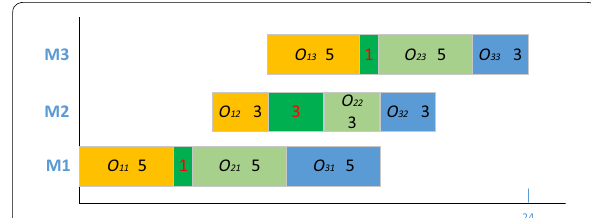
Figure 3 Gantt chart of increasing the number of total jobs